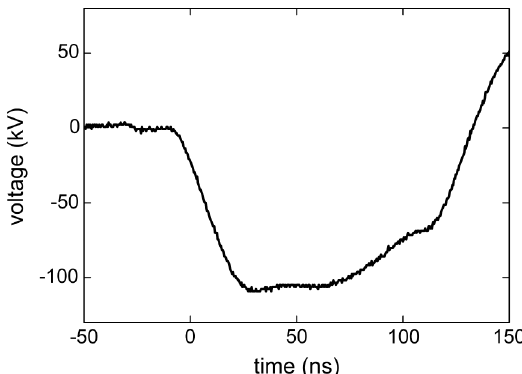
FIG. 3. Typical voltage waveform of the improved trigger generator. The maximum voltage is 110 kV with zero-to- maximum rise time of 38 ns, and a FWHM of 110 ns. The trigger generator has ten output cables with the same length.